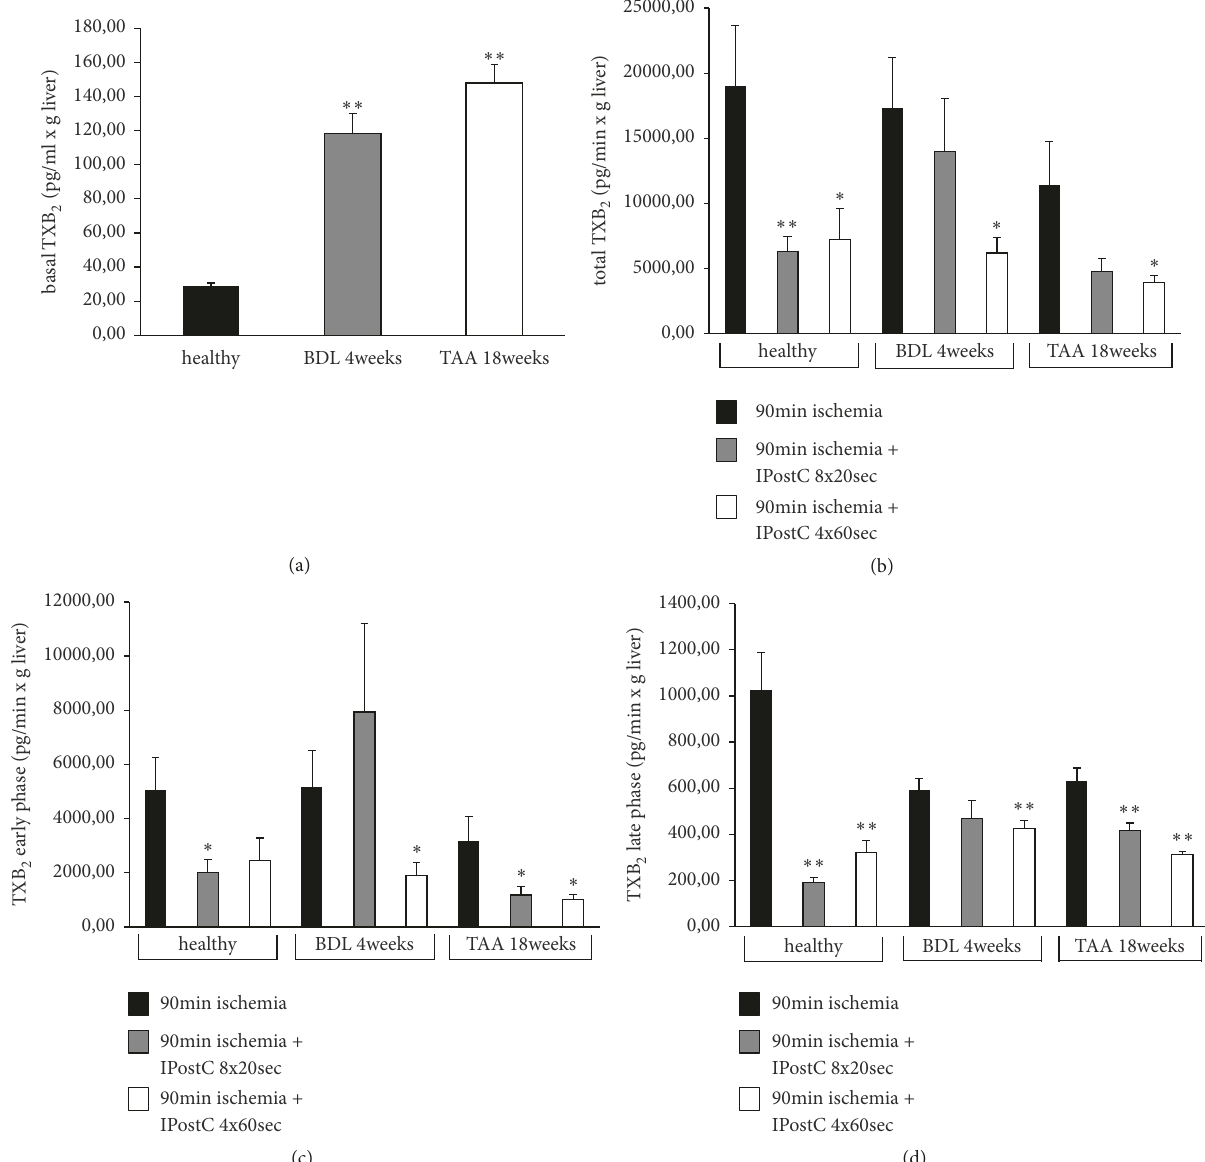
Figure 6: Thromboxane B in healthy, fibrotic, and cirrhotic livers after warm ischemia ± IPostC . The induction of liver fibrosis using bile duct 2 ligation (BDL) over 4 weeks or the induction of liver cirrhosis using thioacetamide (TAA) administered via drinking water over 18 weeks in male SD rats was performed. The healthy, fibrotic, and cirrhotic livers were perfused for 30 min and stored at 37 ∘ C for 90 min, followed by reperfusion for 90 min. After ischemia, IPostC interventions using 8x20 sec and 4x60 sec (control and intervention groups, each with n=8) were carried out. Thromboxane B 2 (TXB 2 ) was measured in the collected perfusate using an enzyme-linked immunosorbentassay. The values for TXB 2 are shown as basal values (a), in total (b) and during the early phase (minute 0 to 40; (c)) and the late phase (minute 50 to 90; (d)) of reperfusion. All data are expressed as the mean ± SEM. Significant values are specified as ∗ p < 0.05 and ∗∗ p < 0.01.